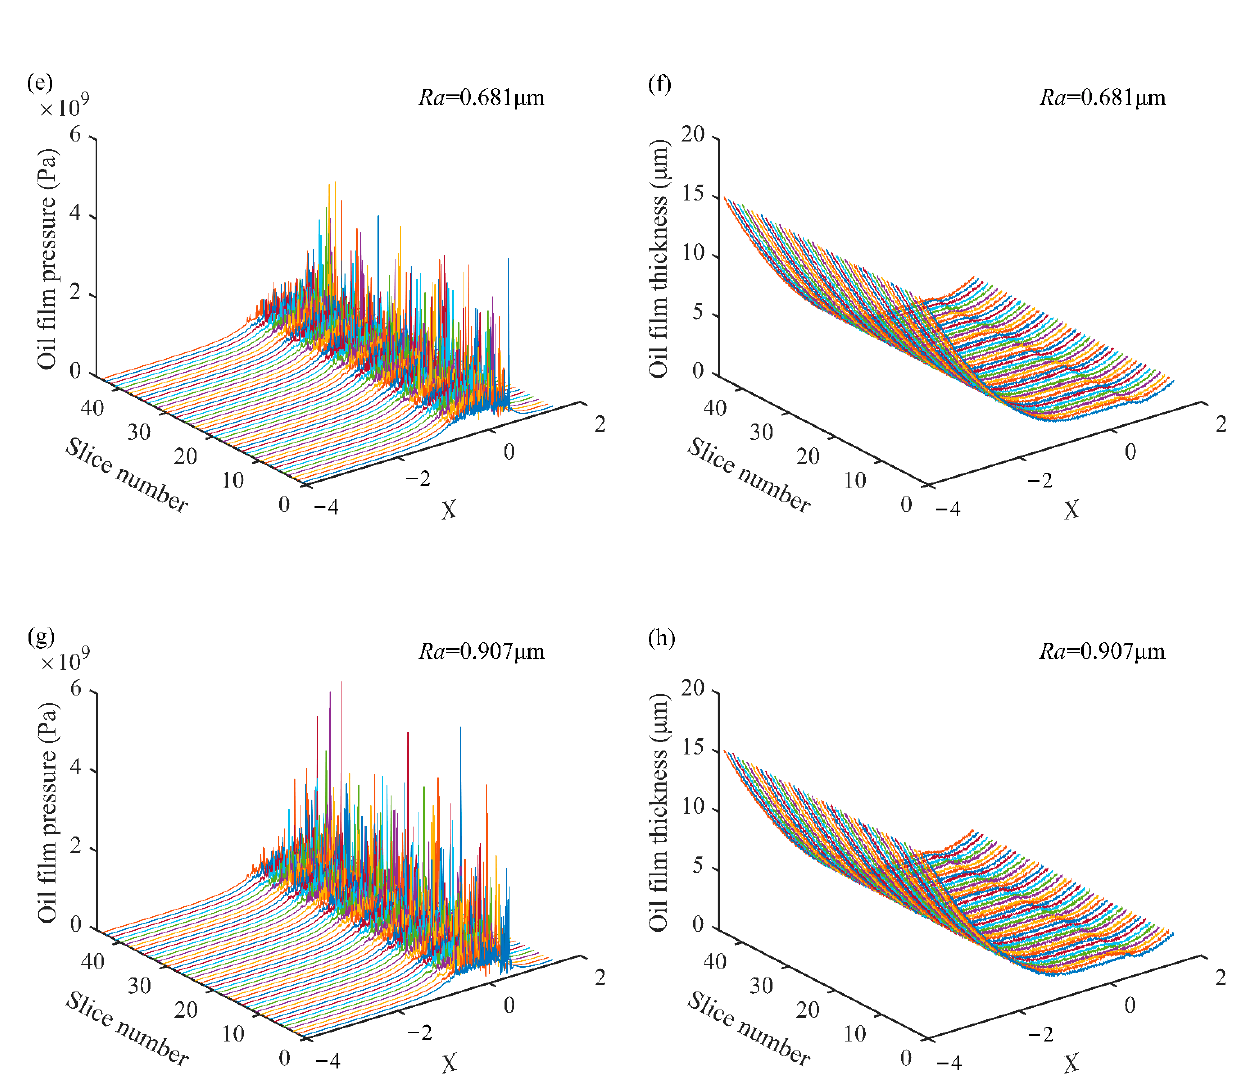
Figure 8. OFP and OFT curve of rough surface: ( a ) OFP with Ra = 0.907 μ m; ( b ) OFT with Ra = 0.907 μ m; ( c ) OFP with Ra = 1.609 μ m; ( d ) OFT with Ra = 1.609 μ m; ( e ) OFP with Ra = 3.256 μ m; ( f ) OFT with Ra = 3.256 μ m; ( g ) OFP with Ra = 6.238 μ m; ( h ) OFT with Ra = 6.238 μ m. Table 2. Roughness and fractal